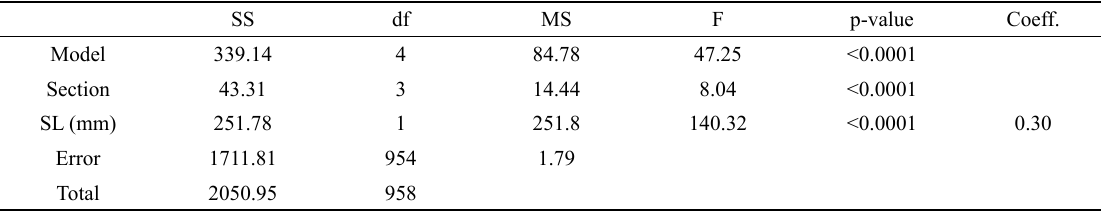
Table 1. – Analysis of variance of mean values of the standardized RNA/DNA index (RD) for Engraulis anchoita larvae collected in different oceanographic sections (S1-S4) in December 2018. Standard length was used as a co-variable (ANCOVA). SS, Sum of quares; MS, Mean squares